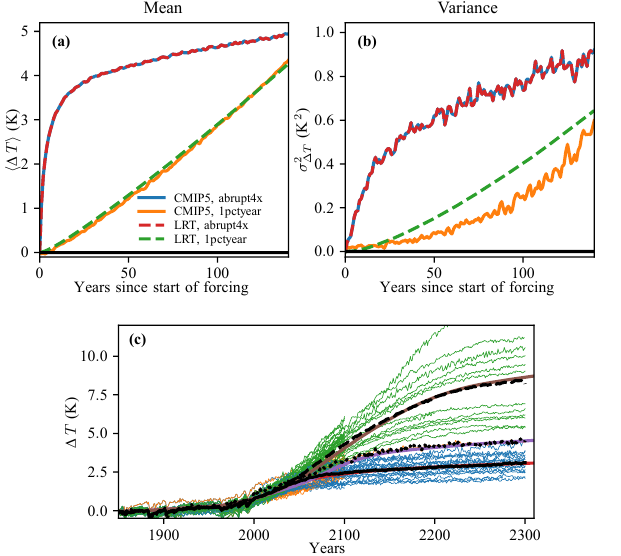
Figure 1. Ensemble mean ( a ) and variance ( b ) of temperature re- sponse from CMIP5 (solid) and LRT reproduction (dashed). Year 0 gives the start of the perturbation. ( c ) Reconstruction of RCP tem- perature evolution from concentration pathways using CO 2 only. Blue, orange and green lines gives CMIP5 data for RCP4.5, RCP6.0 and RCP8.5, respectively, with the ensemble mean given in black solid (RCP4.5), dotted (RCP6.0) and dashed (RCP8.5) black. Re- construction using CO 2 radiative forcing in red (RCP4.5), purple (RCP6.0) and brown